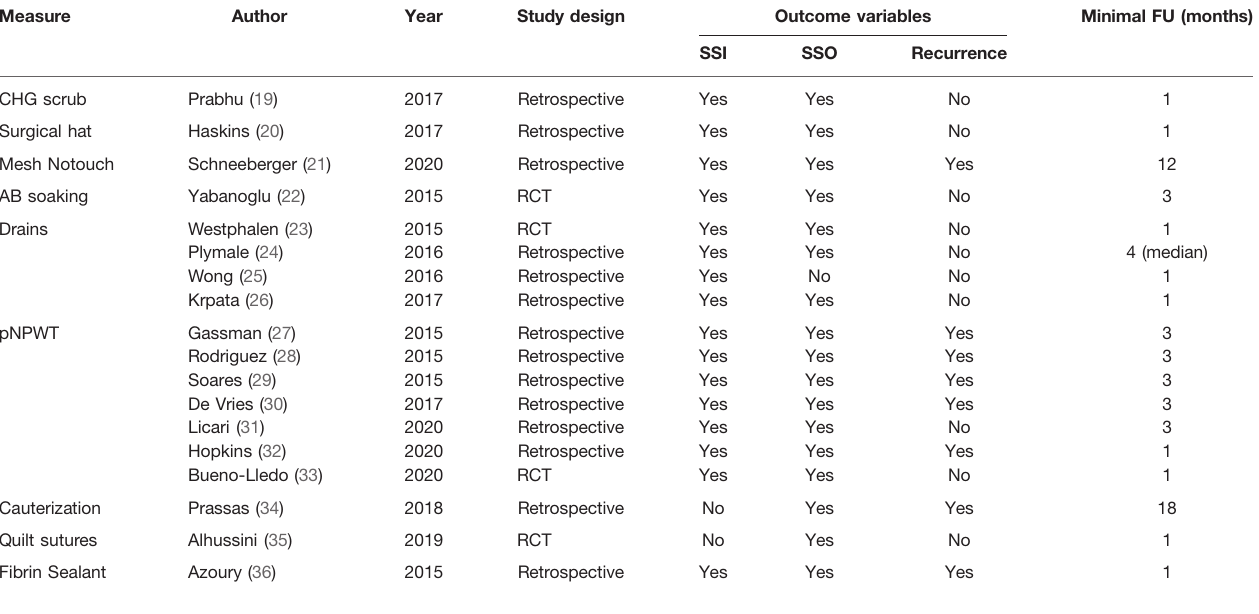
TABLE 1 | Included studies with characteristics, study endpoints and